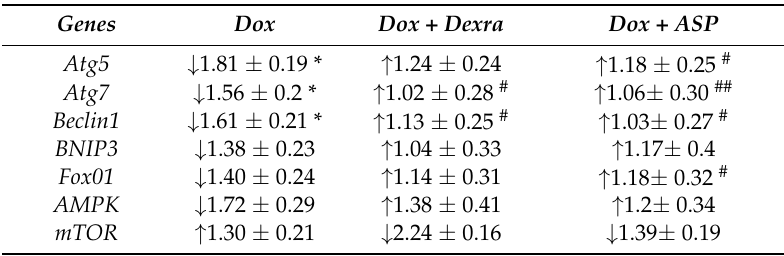
Legend to Figure: Arrows indicate fold difference relative to the control set as 1. ↓ : Down regulated; ↑ : Up regulated. Results are expressed as the mean ± SEM. * p < 0.05 versus control and # p < 0.05 and ## p < 0.01 versus Dox.